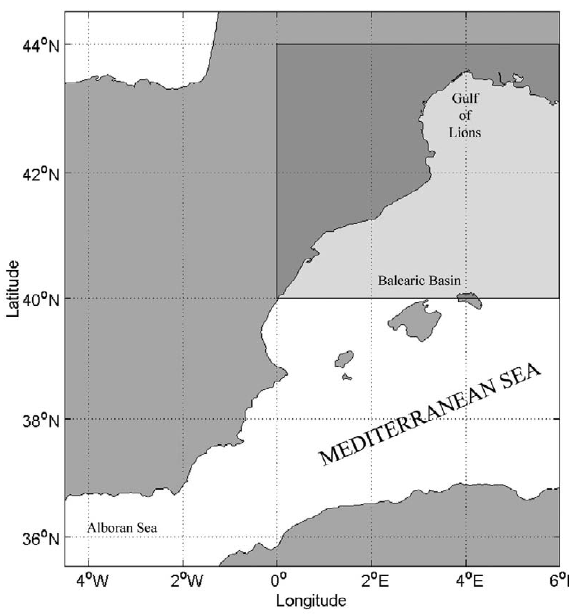
Fig . 1. – Geographic location of the study